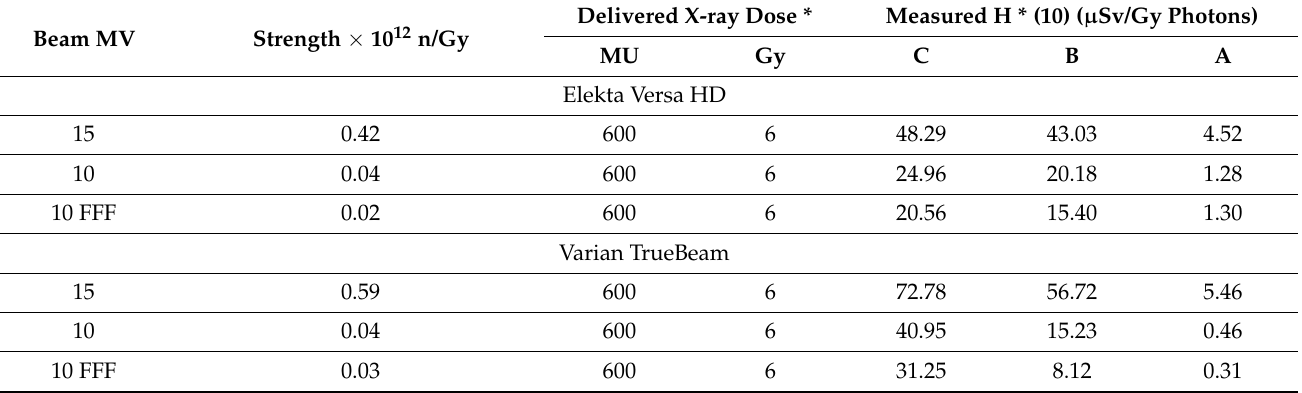
Table 2. Results of neutron dose equivalent rate measurements at points C, B, and A. Delivered X-ray Dose Beam MV Strength × 10 12 n/Gy